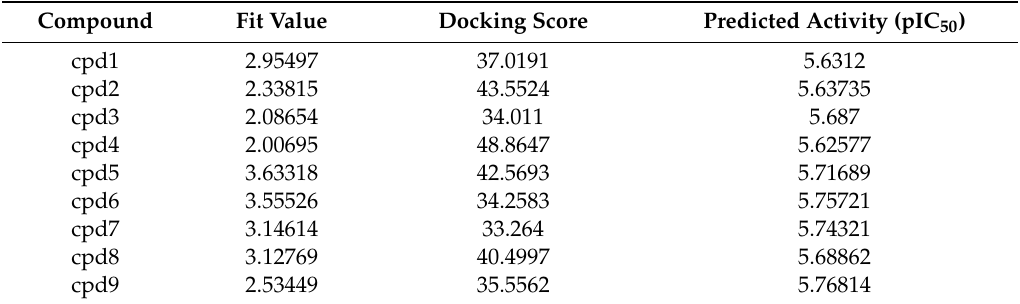
Table 4. The nine hit compounds’ parameters, which include docking score, pharmacophore fit values, and pIC 50 values.